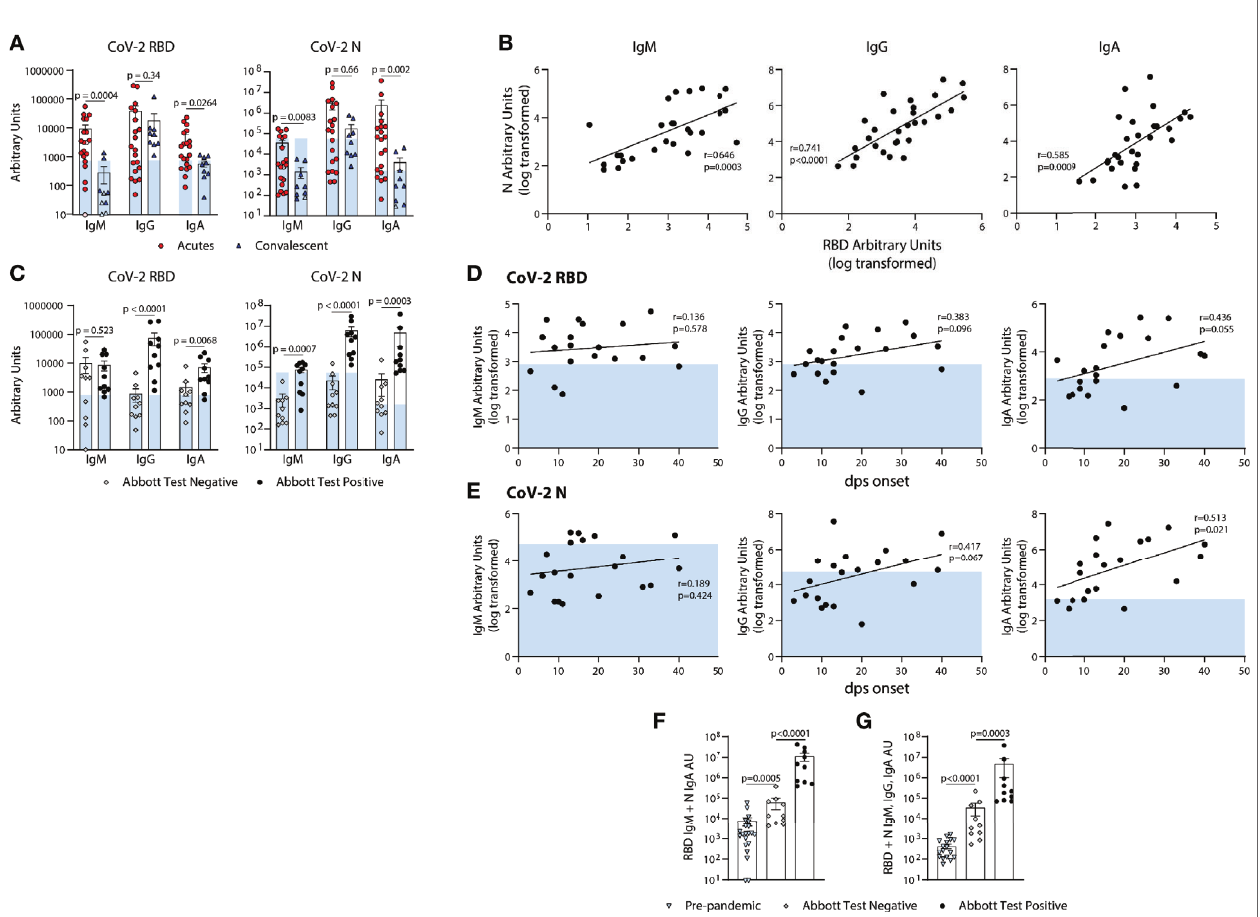
FIGURE 5 | Quanti fi cation of the relative levels of IgM, IgG, and IgA-reactive SARS-CoV-2-RBD and N antibodies from acute and convalescent SARS-CoV-2 infected subjects. (A) Arbitrary Units (AUs) of SARS-CoV-2 RBD and N reactive IgM, IgG, and IgA of acute and convalescent subjects. Open and solid symbols represent negative and positive results, respectively, as determined by our Metric 1 described in Methods. (B) Correlation between SARS-CoV-2 RBD and N IgM, IgG, and IgA log transformed AUs. Values were log-transformed to obtain a parametric distribution. (C) Quanti fi cation of SARS-CoV-2 RBD and N reactive IgM, IgG, and IgA of acute subjects regrouped based on results from Abbott ’ s SARS-CoV-2 IgG CMIA. Correlation between SARS-CoV-2 RBD (D) and N (E) IgM, IgG, and IgA AUs (log transformed) with the number of days post symptom (dps) onset at time of sample collection for acute subjects. Quanti fi cation of SARS-CoV-2 RBD reactive IgM and N reactive IgA (F) and RBD & N reactive for IgM, IgG, and IgA (G) for pre-pandemics (n = 19) and Acutes re-classi fi ed based on Abbott test results. Light blue bars depict AU range of pre-pandemics for each respective antigen and isotype. Statistical analyses were performed using an unpaired non-parametric Mann-Whitney t-test in (A, C, F, G) and Pearson ’ s correlation of normally distributed log transformed AU values in (B, D, E) dps, days post